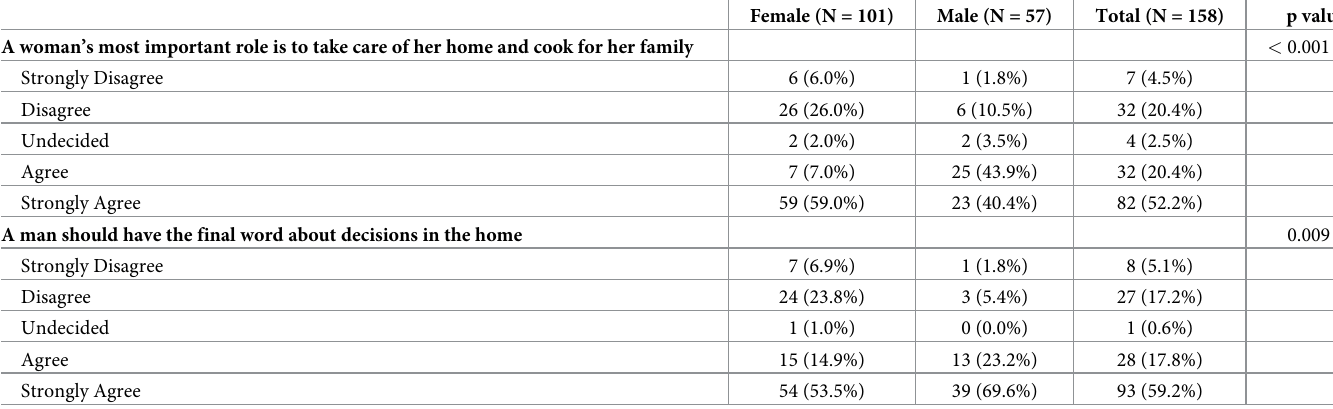
Table 2. Perception of gender roles by